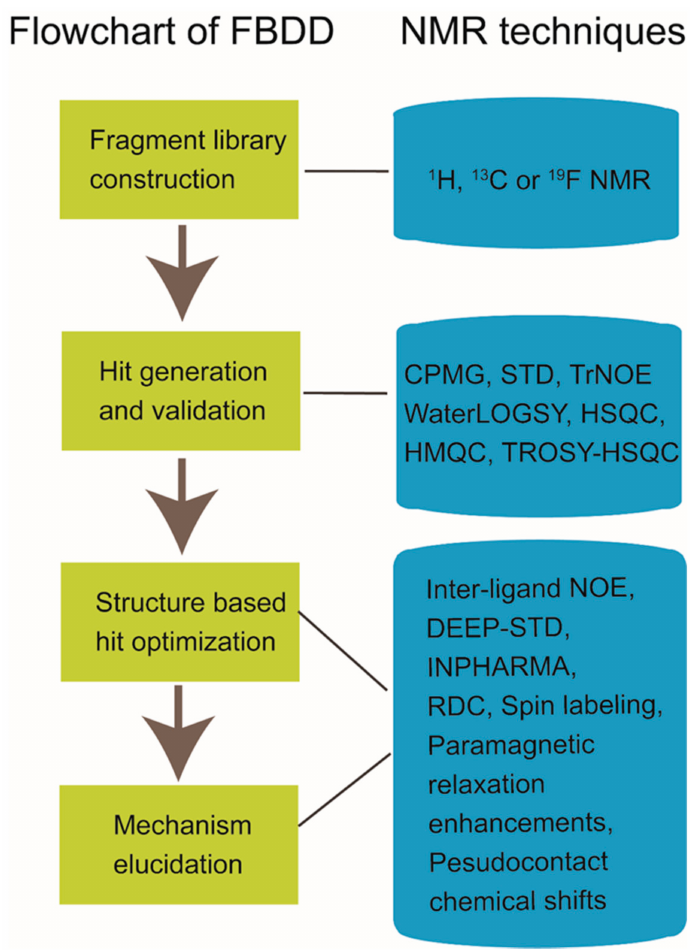
Figure 1. Nuclear magnetic resonance (NMR) applications in fragment-based drug